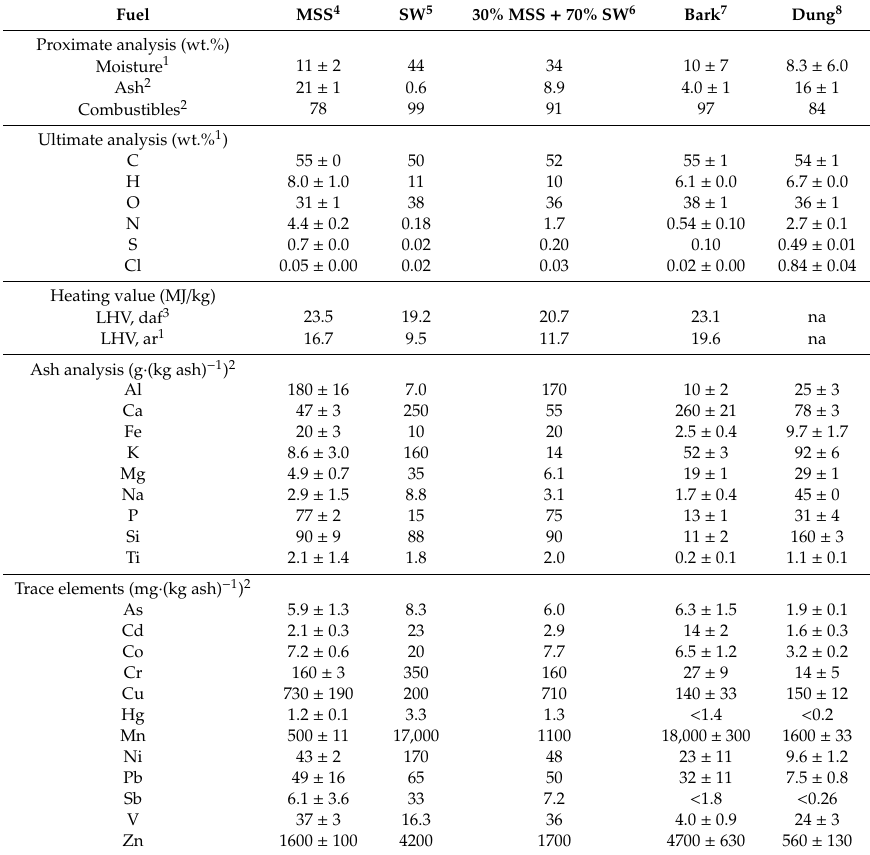
Table 1. Some analytical properties of the raw fuels and calculated properties of the mixture, n = 3. Fuel